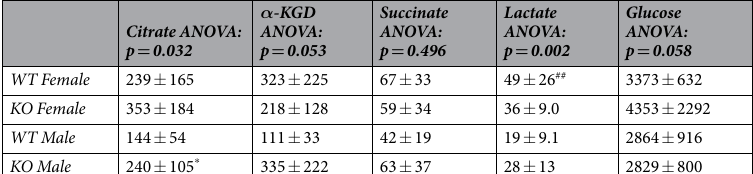
Citrate ANOVA: p = 0.032